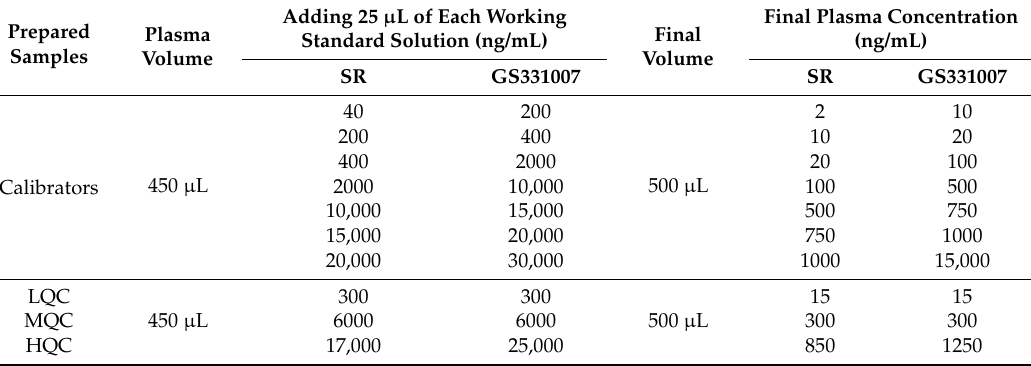
Table 5. Standard curve concentrations and quality control samples for sofosbuvir (SR) and its metabolite, GS331007 (LQC: low conc. quality control, MQC: medium conc. quality control, HQC: high conc. quality